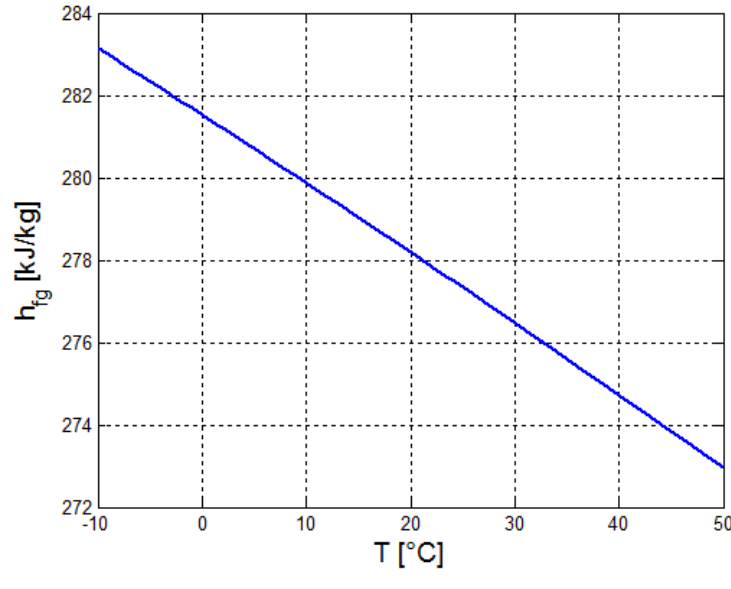
Figure 10. The latent heat of crude oil.